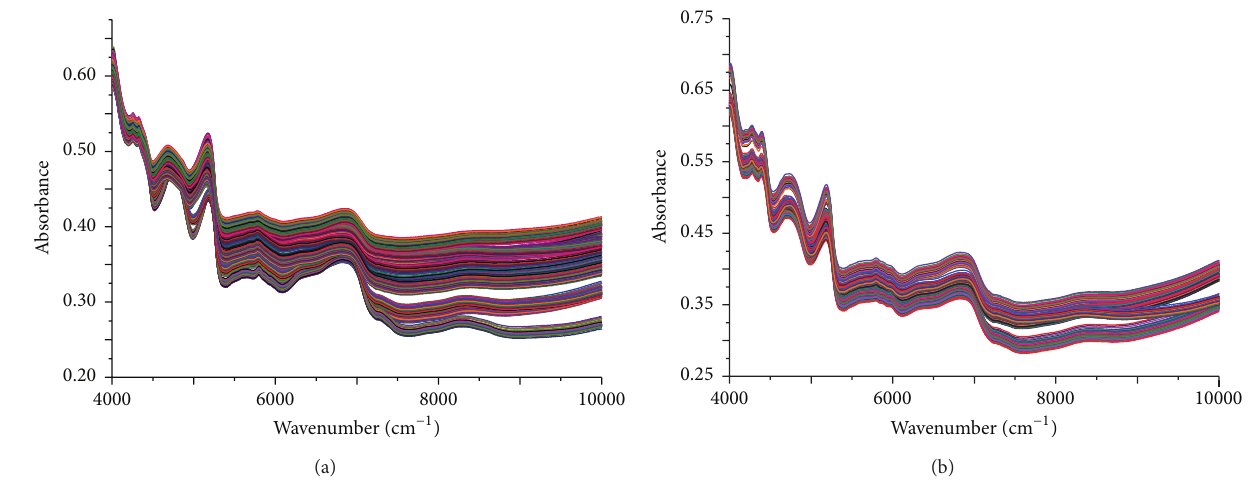
Figure 3: The raw NIR spectra of Hibiscus mutabilis L. (a) and Berberidis radix (b).